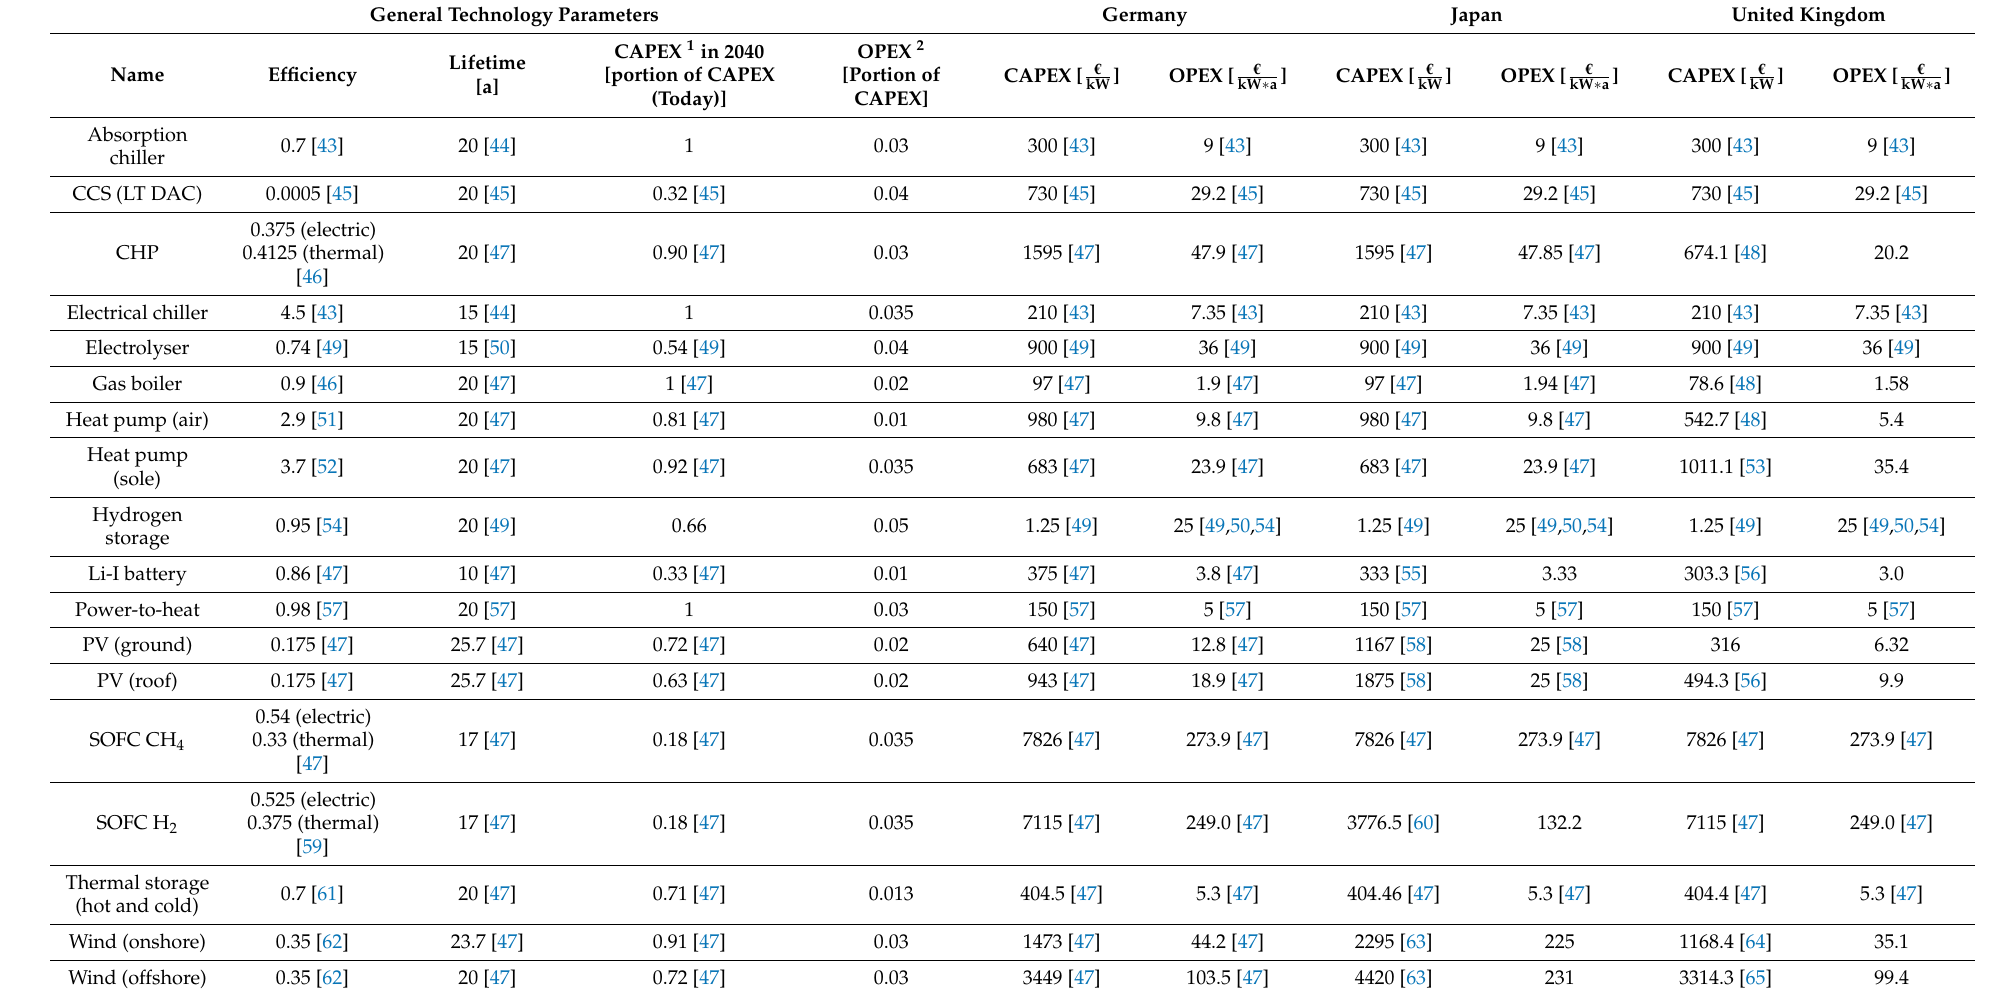
Table 1. Technology